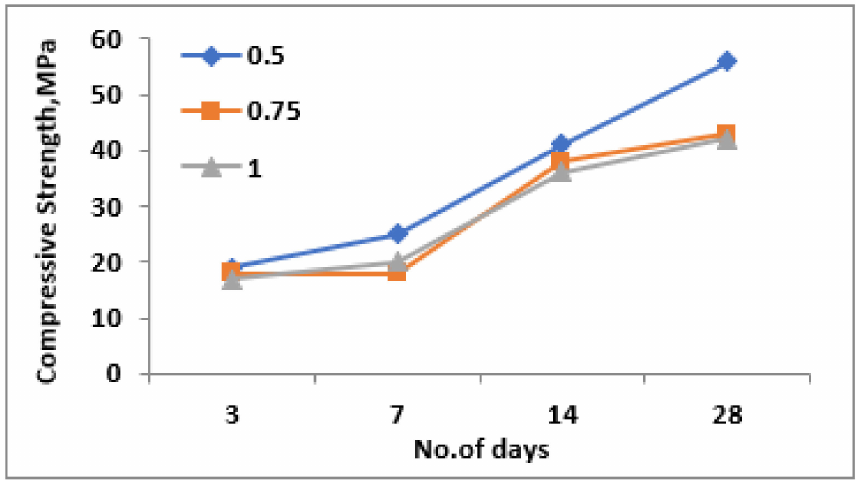
Figure 8. Compressive strength for different NaOH/Na 2 SiO 3